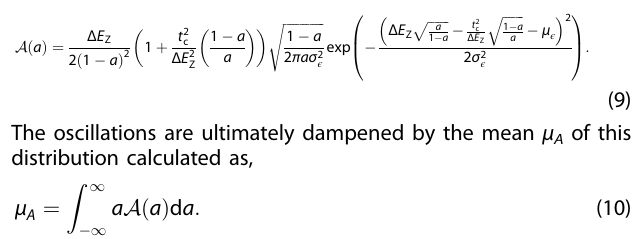
(exponential decay) if caused by a few nearby TLFs 34 , or 2 (Gaussian decay) if caused by a large ensemble of fl uctuators 35 .